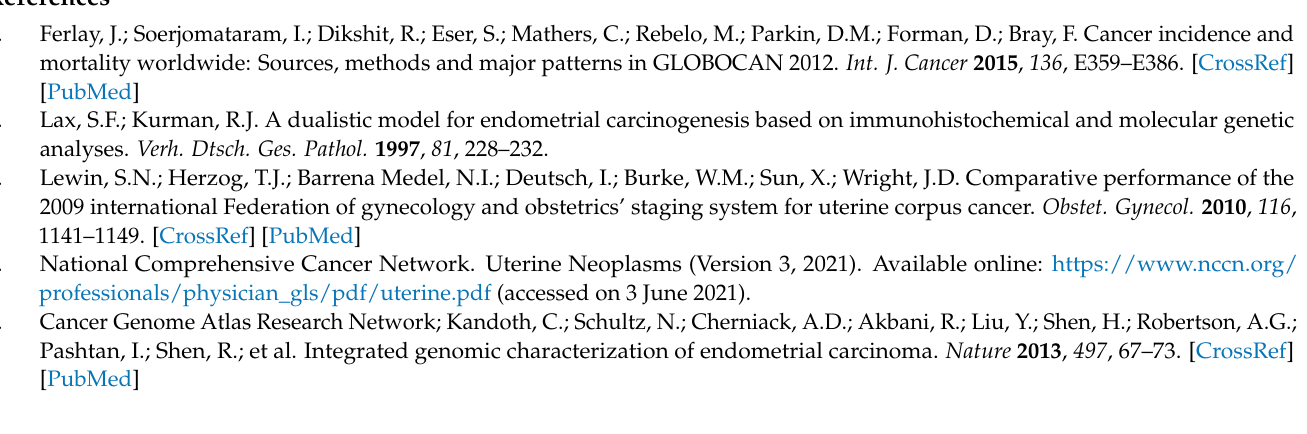
Supplementary Figure S4. Effect of MET mutations on the cellular function of the endometrial cancer KLE cell line. (A,B) A representative image and quantitative analysis of invasion and migration assays on various clones of MET mutation. (C) Proliferation assay. Each value represents mean ± SEM from at least 3 different samples. * p < 0.05; ** p < 0.01. Supplementary Figure S5. SCID mice were subcutaneously inoculated with endometrial cancer RL95-2 cells carrying either wild-type or mutant MET (N375S, G1085R, or G1087E). The mice were treated with observation alone (A), cisplatin 1 mg/kg (B), crizotinib 25 mg/kg (C), or SU1127 6 mg/kg (D) 1 week after tumor inoculation. The tumor size at the day when mice were sacrificed is shown. Supplemental Figure S6. Comparison between TCGA and NCKUH cohorts. (A) Distribution of ages at initial diagnosis, FIGO stages, histologic subtypes in TCGA and NCKUH cohorts. (B) The clinical outcome of TCGA and NCKUH cohorts. There was no significant difference in these parameters between the two cohorts. (C) High impact of gene aberration on genomic function. Top 23 genes with high impact of genomic alterations are listed in each cohort. (D) The overall survival rate was not affected by MET mutations in the TCGA cohort. Supplementary Figure S7. DNA polymerase epsilon (POLE) mutations in advanced endometrial cancer. (A) Mutation patterns of POLE in the NCKUH cohort. (B) Overall survival in the presence or absence of the POLE mutation in the NCKUH cohort. Supplementary Figure S8. The uncropped Western blot figures of Figure 2C. Supplementary Table S1. Sequencing coverage and quality statistics of next-generation sequencing. Supplementary Table S2. Patient characteristics. Supplementary Table S3. The clinical characteristics of patients with and without MET